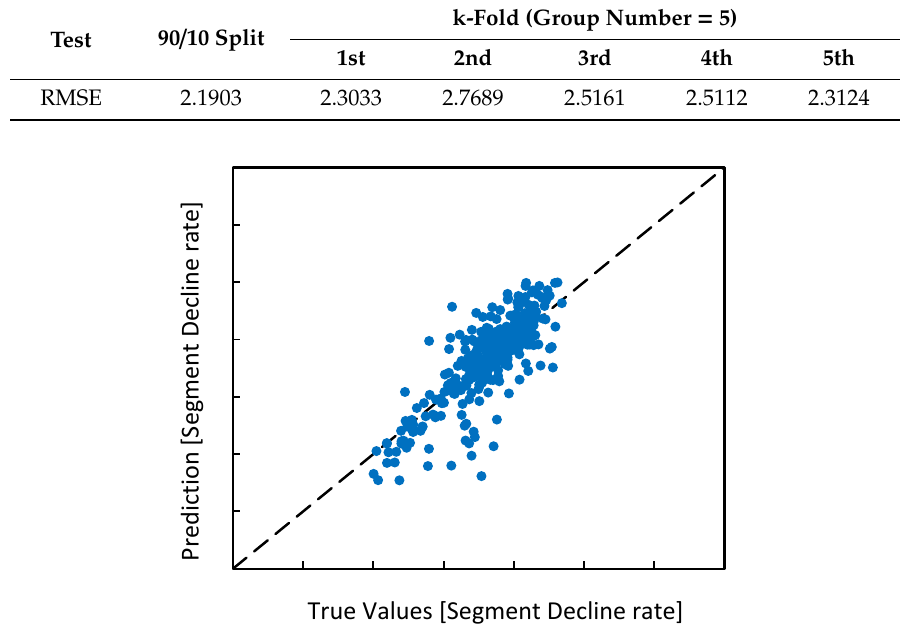
Table 2. Root mean square error (RMSE) result of the randomly 90/10 split and k-fold cross-validation tests.